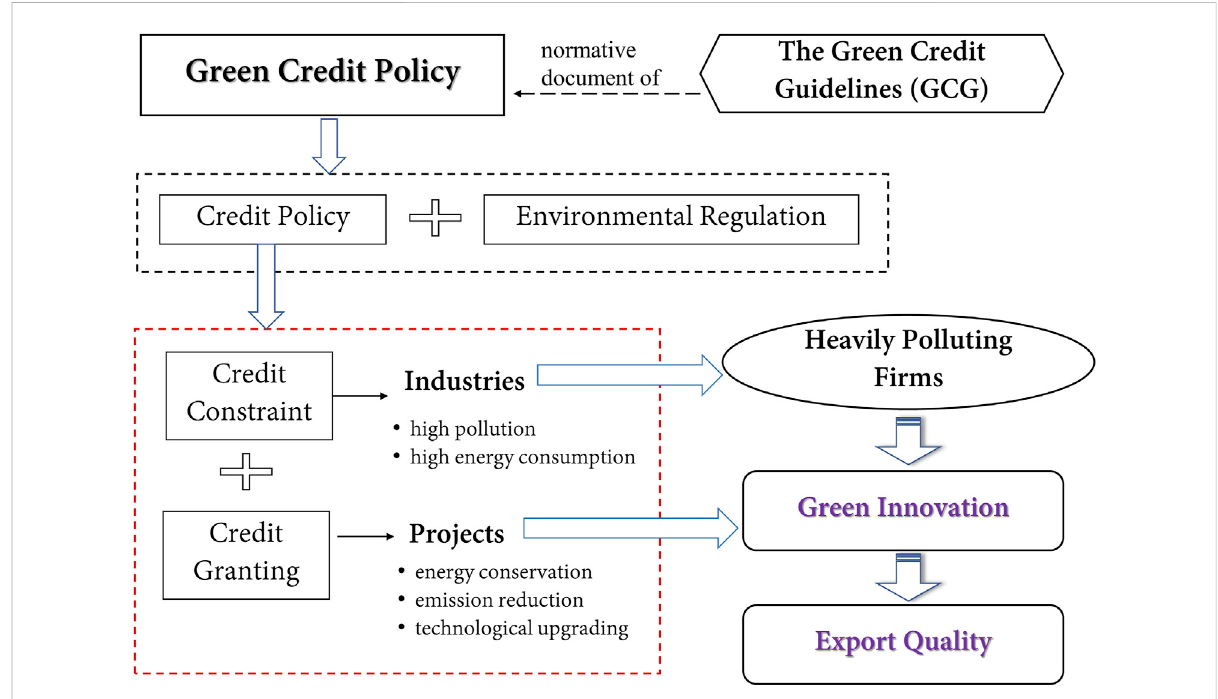
FIGURE 3 Mechanisms that show how the green credit policy affects the export